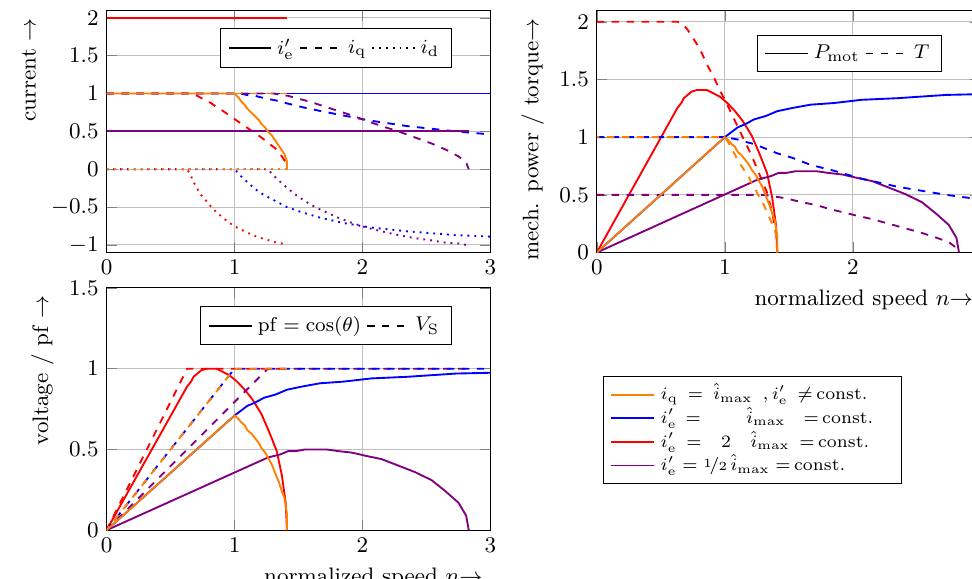
Figure 5. Influence of field weakening on electrical and mechanical quantities over speed for different field weakening approaches. Upper plot shows the influences on current, the middle plot on output power and torque and the bottom plot shows speed-dependent voltage and power factor. The color indicates the discussed method (see upper legend), and the line style indicates the quantity (shown in the legend in each plot). The quantities are related to its value on the corner point for the first approach ( i (cid:48) e = ˆ i max = const.). For all approaches, the magnitude of the stator current is maximum (ˆ i max ). All losses are